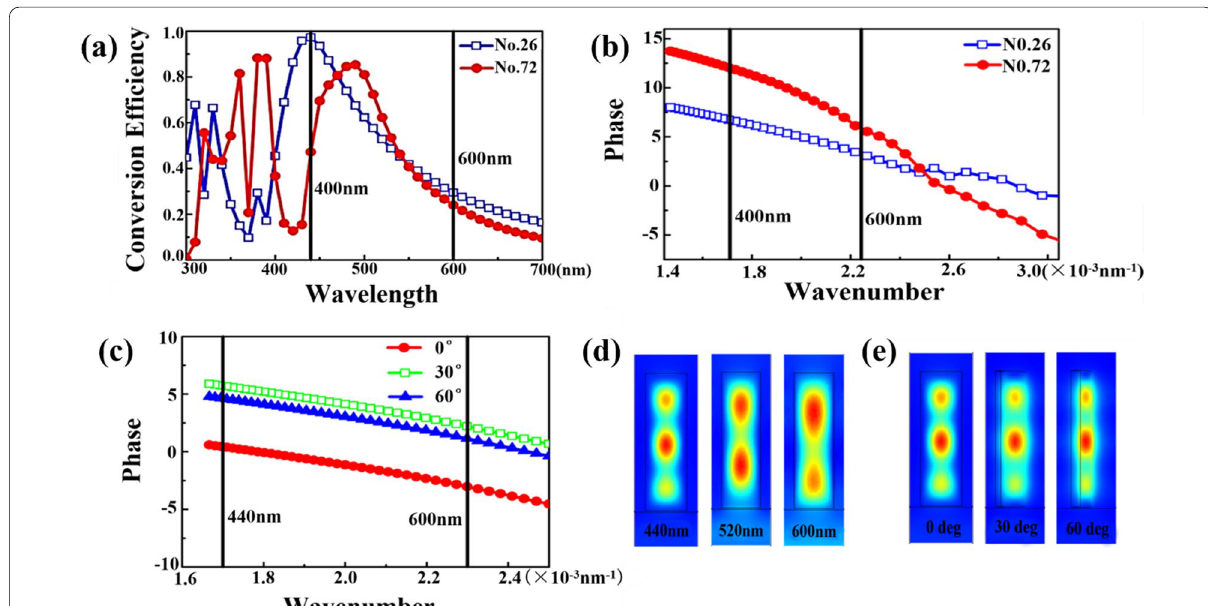
Fig. 2 a Transmittance spectrum and b transmission phase spectrum of structural units under group 26 and 72. c Transmission phase spectrum of the corresponding structural units at rotation angles of 0°, 30°, and 60°, respectively. d Normalized magnetic field distributions of the corresponding structural units under the 26th group at incident light wavelengths of 440 nm, 520 nm and 600 nm, respectively. e Normalized magnetic field distributions of the corresponding structural units at rotation angles of 0°, 30° and 60°, respectively